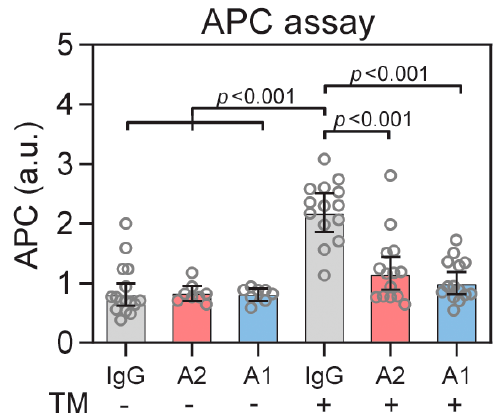
Figure 4. TM-dependent activation of protein C (APC) can be inhibited with ANGPT2 or ANGPT1. Human healthy donor plasma was supplemented with sTM (20 nM) and incubated with 40 nM ANGPT2, IgG or ANGPT1. Data are presented as mean ± 95% CI. Statistical comparison from one-way ANOVA with Bonferroni post hoc test.